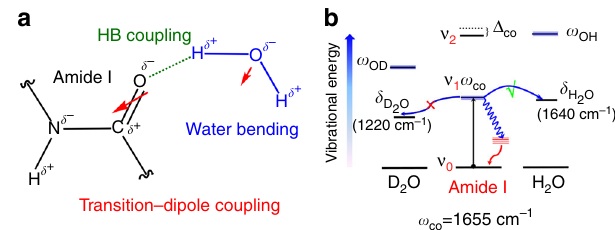
Fig. 3 Coupling scheme and energy diagram. a Interaction between amide carbonyl and water through hydrogen bonding (HB) and transition – dipole coupling. b Energy-level depiction of the vibrational relaxation of the amide